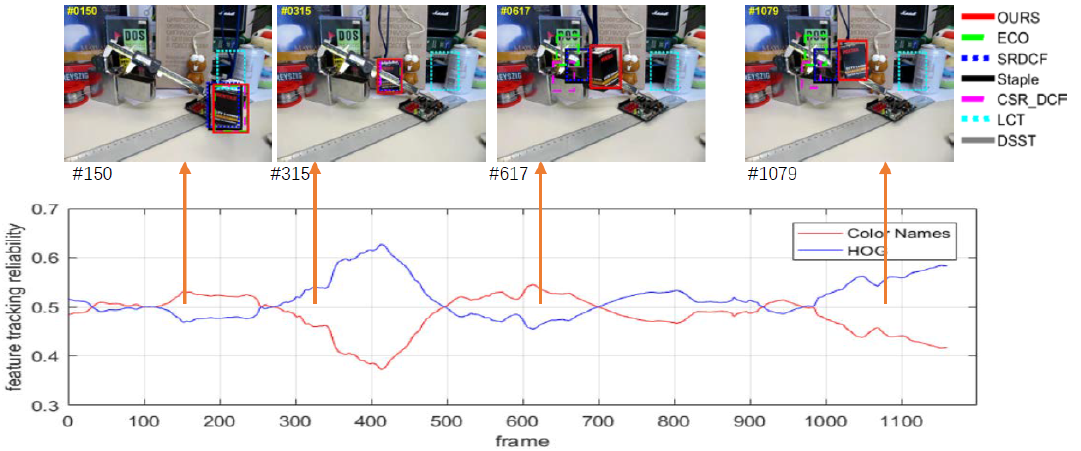
Figure 3. Visualization of the feature weights change in adaptive feature